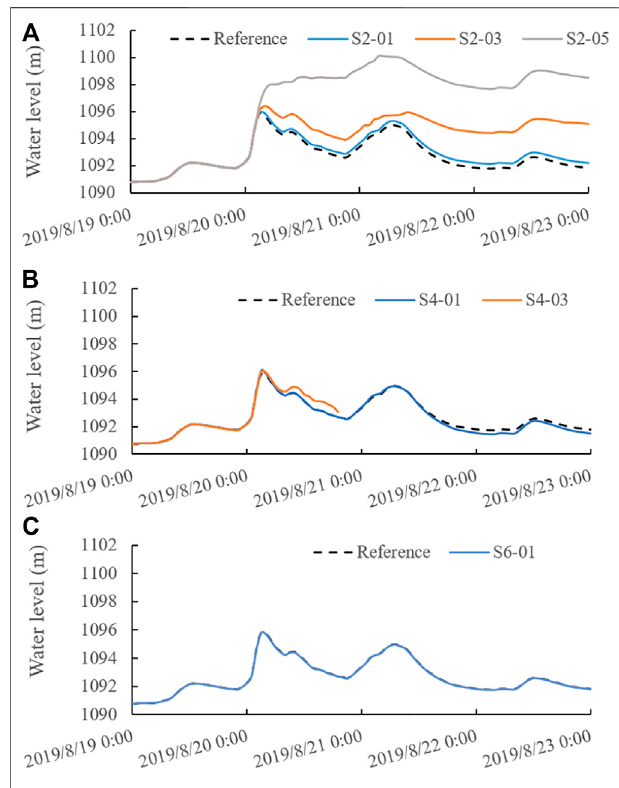
FIGURE 5 | Affected water level at Chainage 7,100 m when sediment in fl ow was from 5,700 m with (A) medium particle size of 0.06 mm with concentration of 1, 3, and 5%; (B) medium particle size of 1 mm with concentration of 1 and 3%. When concentration increased to 5%, river wasclogged,showingnosimulationresults; (C) mediumparticlesizeof3 mm with concentration of 1%. When concentration increased to 3%, river was clogged, showing no simulation